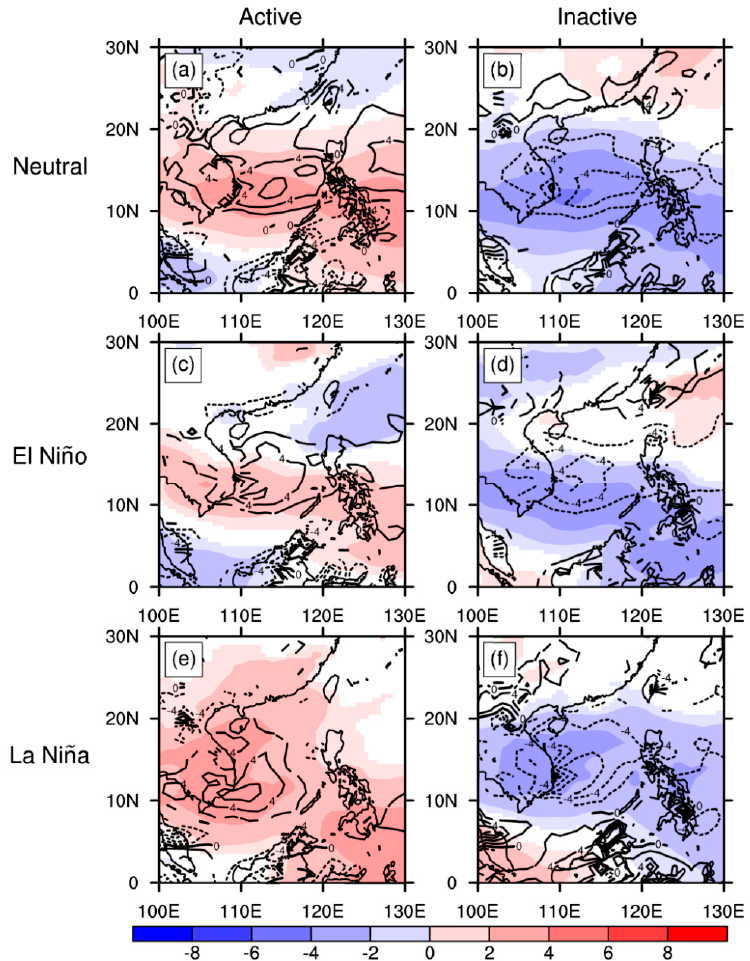
Figure 6. Composite of filtered 600 hPa relative humidity anomalies (shaded; unit: %) and filtered 850 hPa relative vorticity anomalies (contours; unit: 10 − 6 s − 1 ) during the ( a , c , e ) active and ( b , d , f ) inactive MJO phases for neutral years (top panels), the El Niño years (middle panels), and the La Niña years (bottom panels) over the SCS during June–November over the period of 1979–2016. Dashed (solid) contours, negative (positive) filtered anomalies of relative vorticity (interval 2 × 10 − 6 s − 1 ). Only values